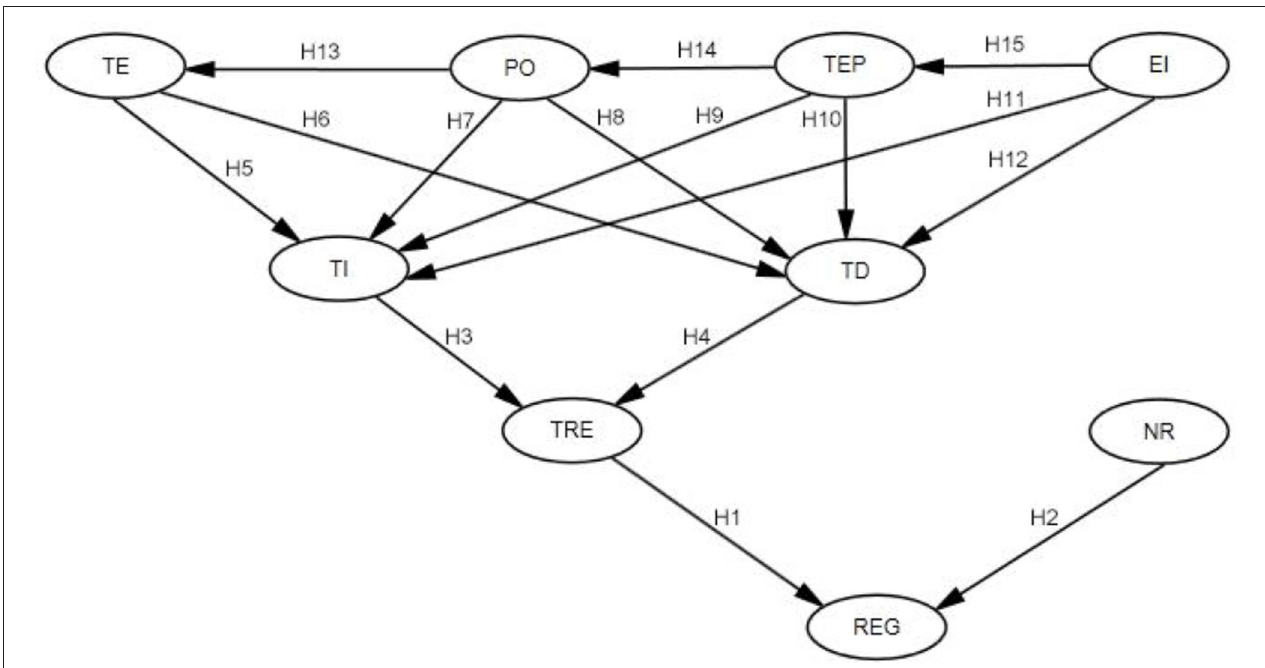
FIGURE 1 | Hypotheses and the propounded conceptual path model of organizational context elements. EI, educational investment; TEP, talent exchanging platform; PO, policy orientation; TE, talent environment; TI, talent introduction; TD, talent development; TRE, talent rooting environment; NR, natural resources; REG, regional economic